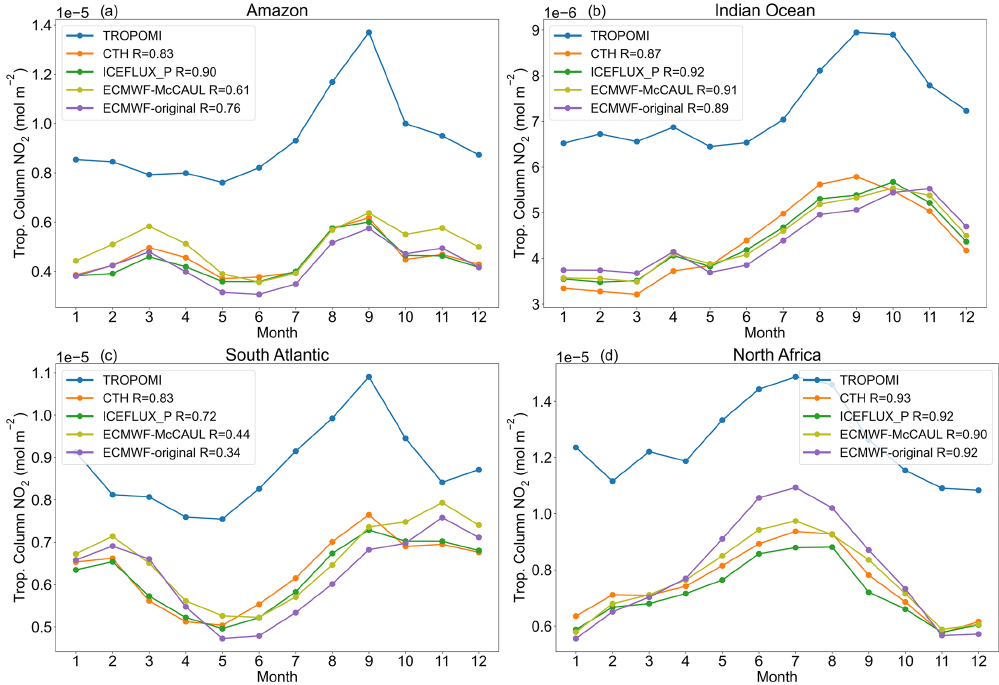
Figure 10. Comparisons of smoothed CHASER and TROPOMI (blue) tropospheric NO 2 columns over four target regions in 2019. Legends show the temporal correlation